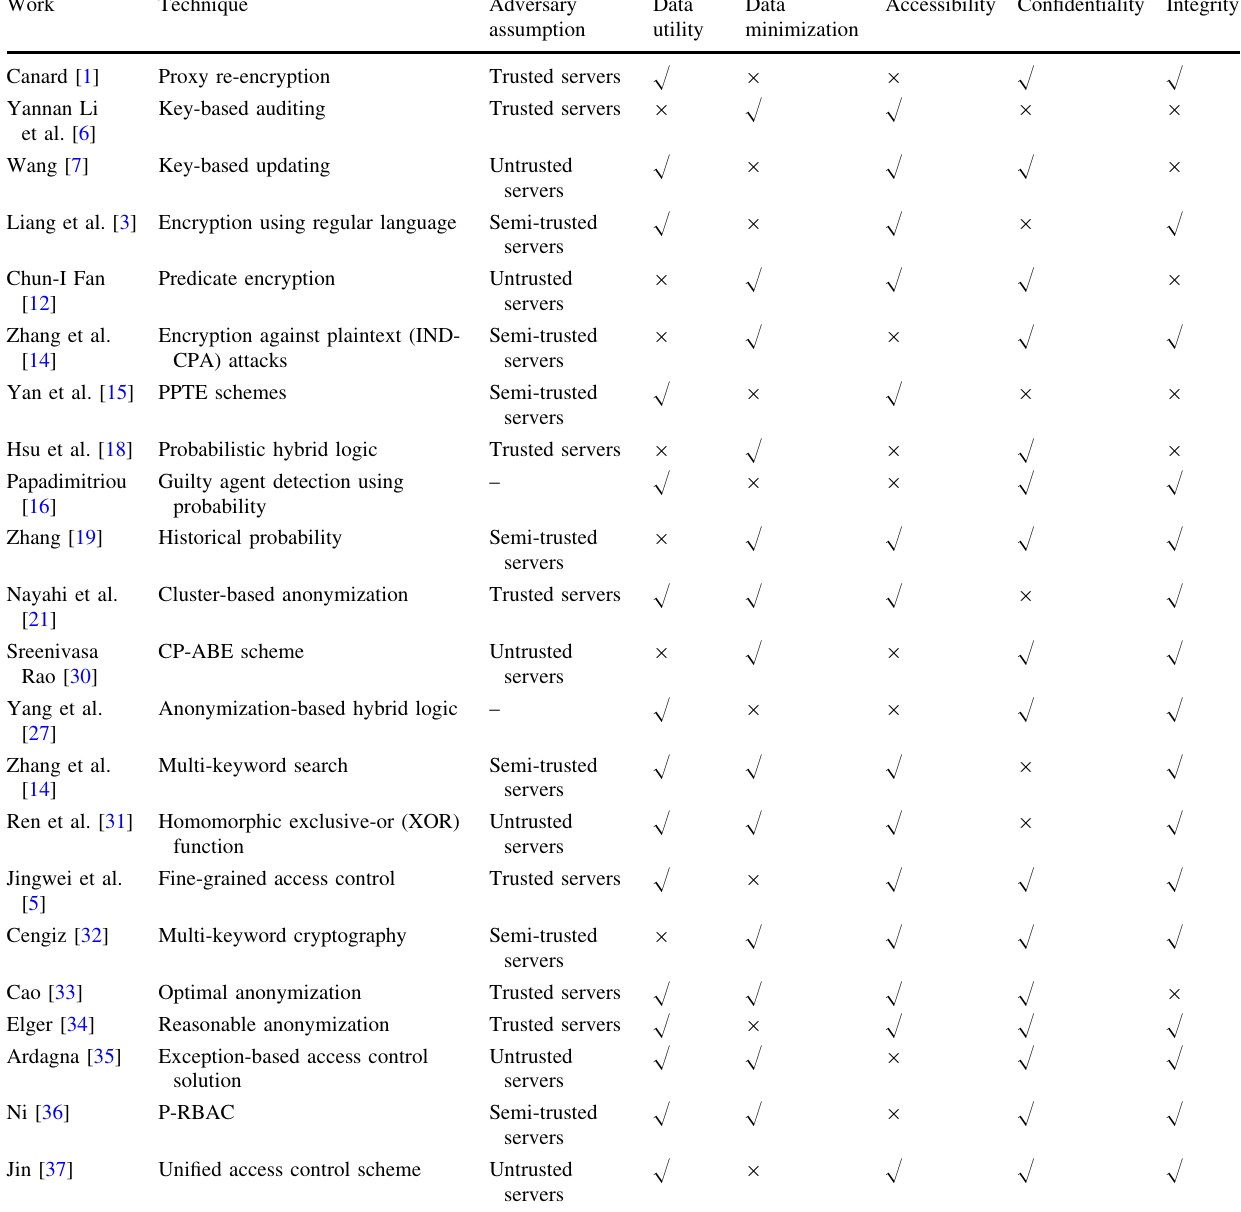
Table 6 Comparison of various privacy-preserving approaches